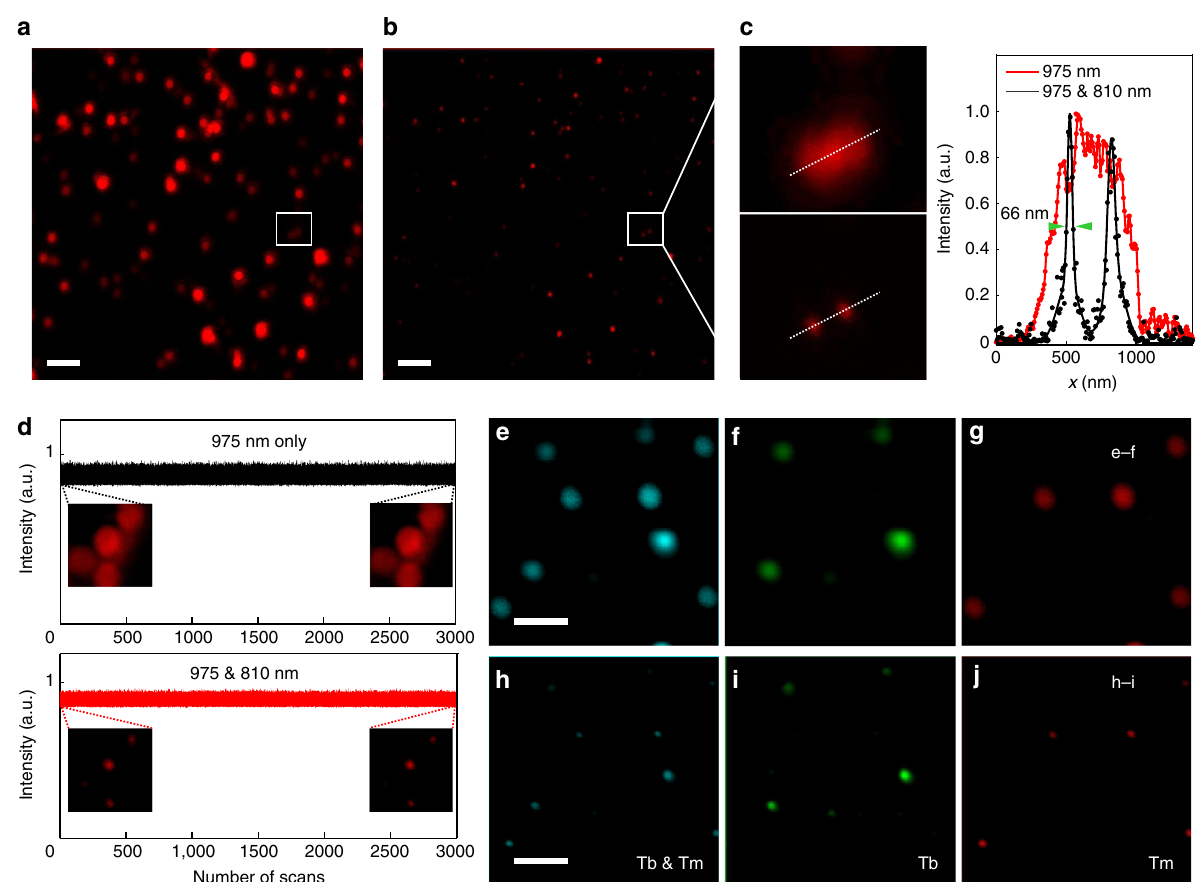
Fig. 3 Dual-color super-resolution microscopy using UCNPs. a NaYF 4 :18% Yb 3+ , 10% Tm 3+ (18.0 ± 1.8 nm in diameter) imaged by the multiphoton laser scanning microscope under 975-nm excitation solely. Scale bar: 2.5 μ m. b The corresponding super-resolution image of the same area